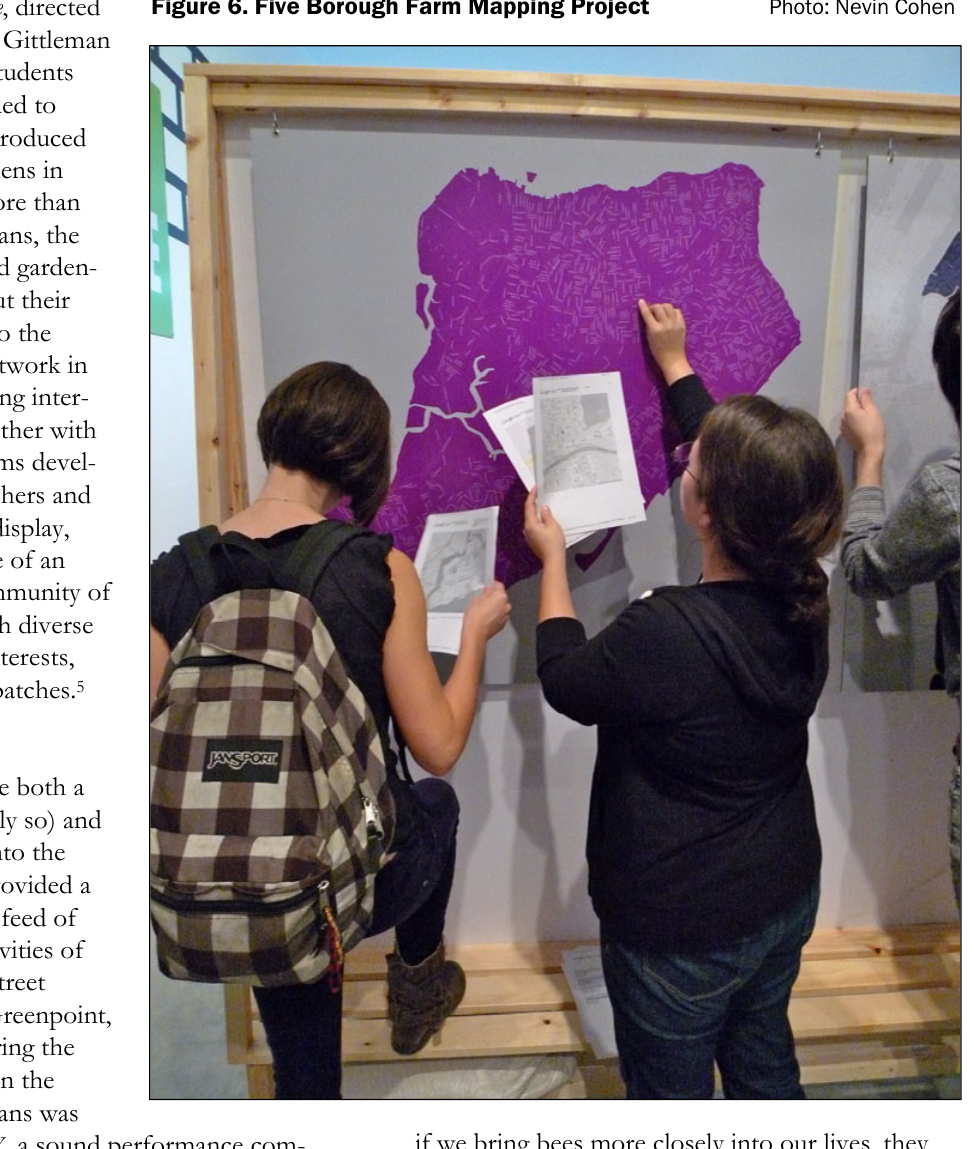
Figure 6. Five Borough Farm Mapping